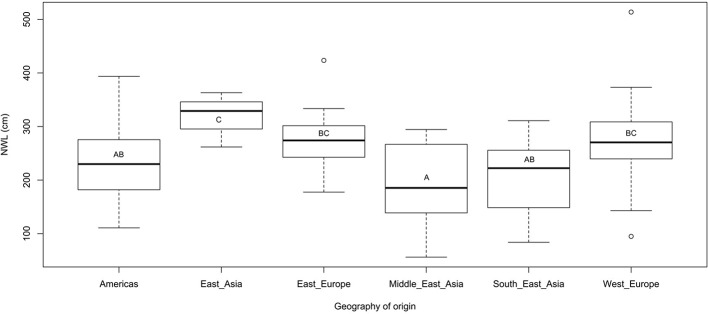
Box plot showing variation in root network length among genotypes based on their geography or origin. Letter/s in the box indicate (P < 0.05) after pairwise comparison.